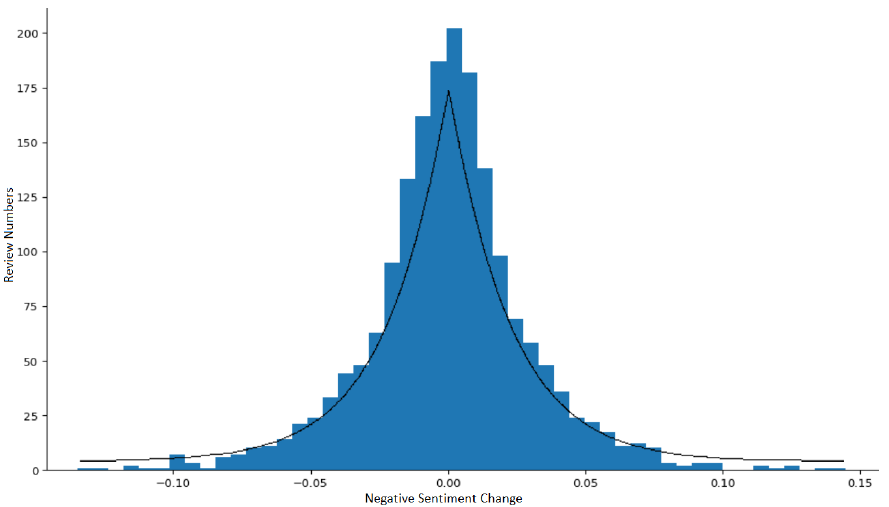
Figure 2. The distribution of the review data negative sentiment